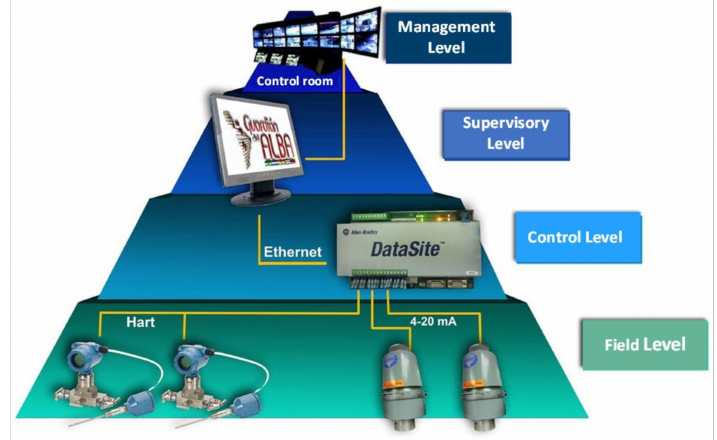
Figure 5. System